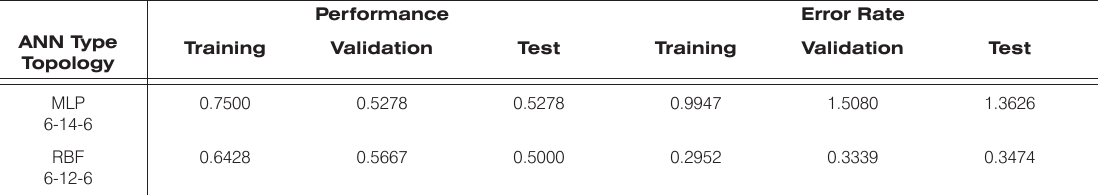
Figure 4. RBF response surfaces for barks, herbs and fruits. Table 1. Performances and RMS values of the ANN